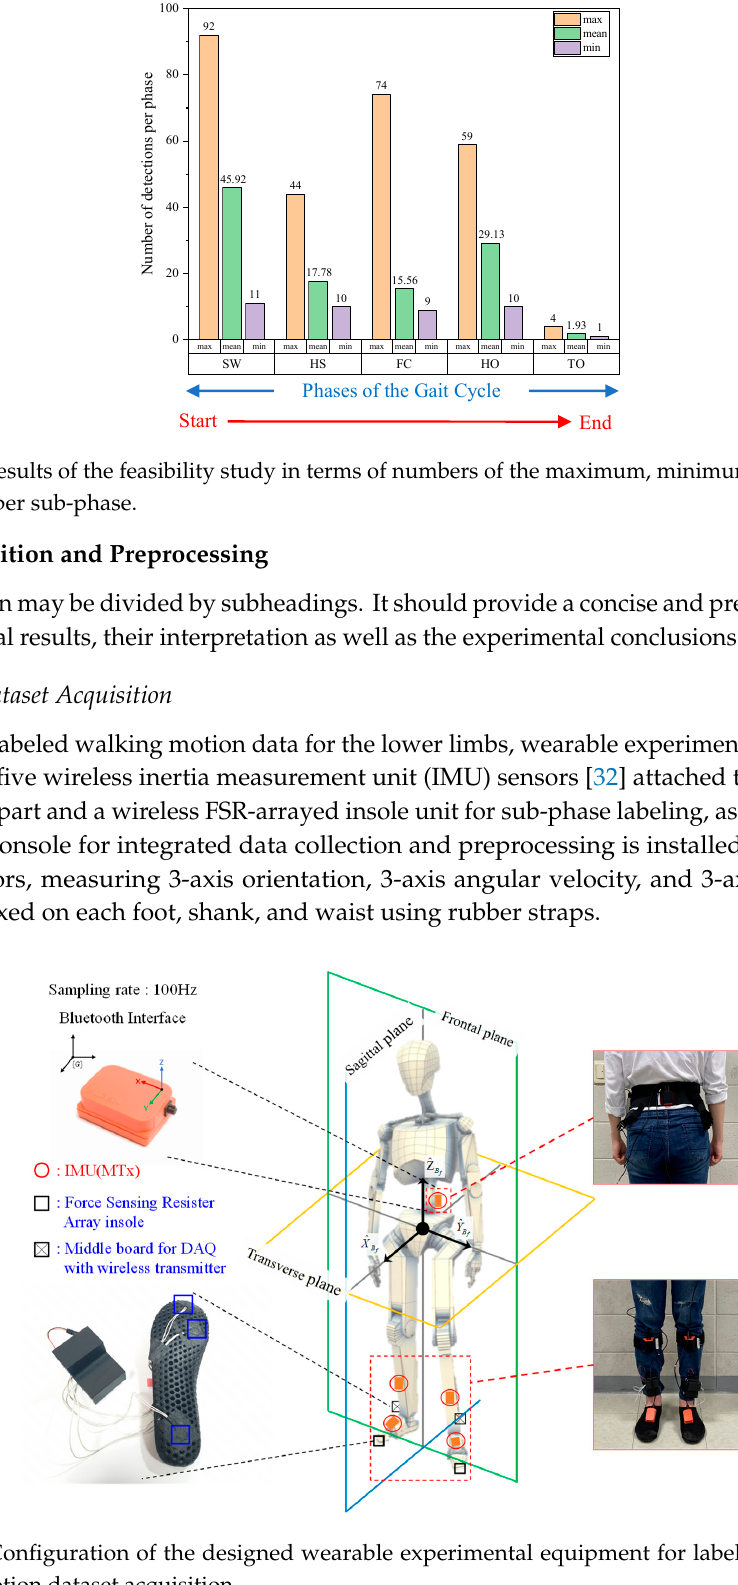
Figure 8. Procedure of standing–stooping calibration motion for creating a common sensor-fixed reference coordinate frame.